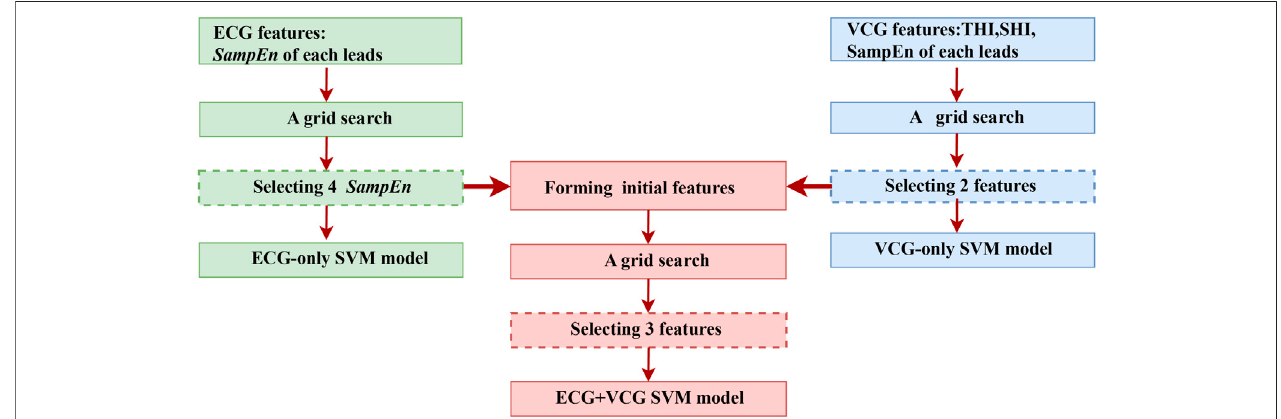
FIGURE 4 | The fl ow chart of feature selection using a grid search on the training dataset